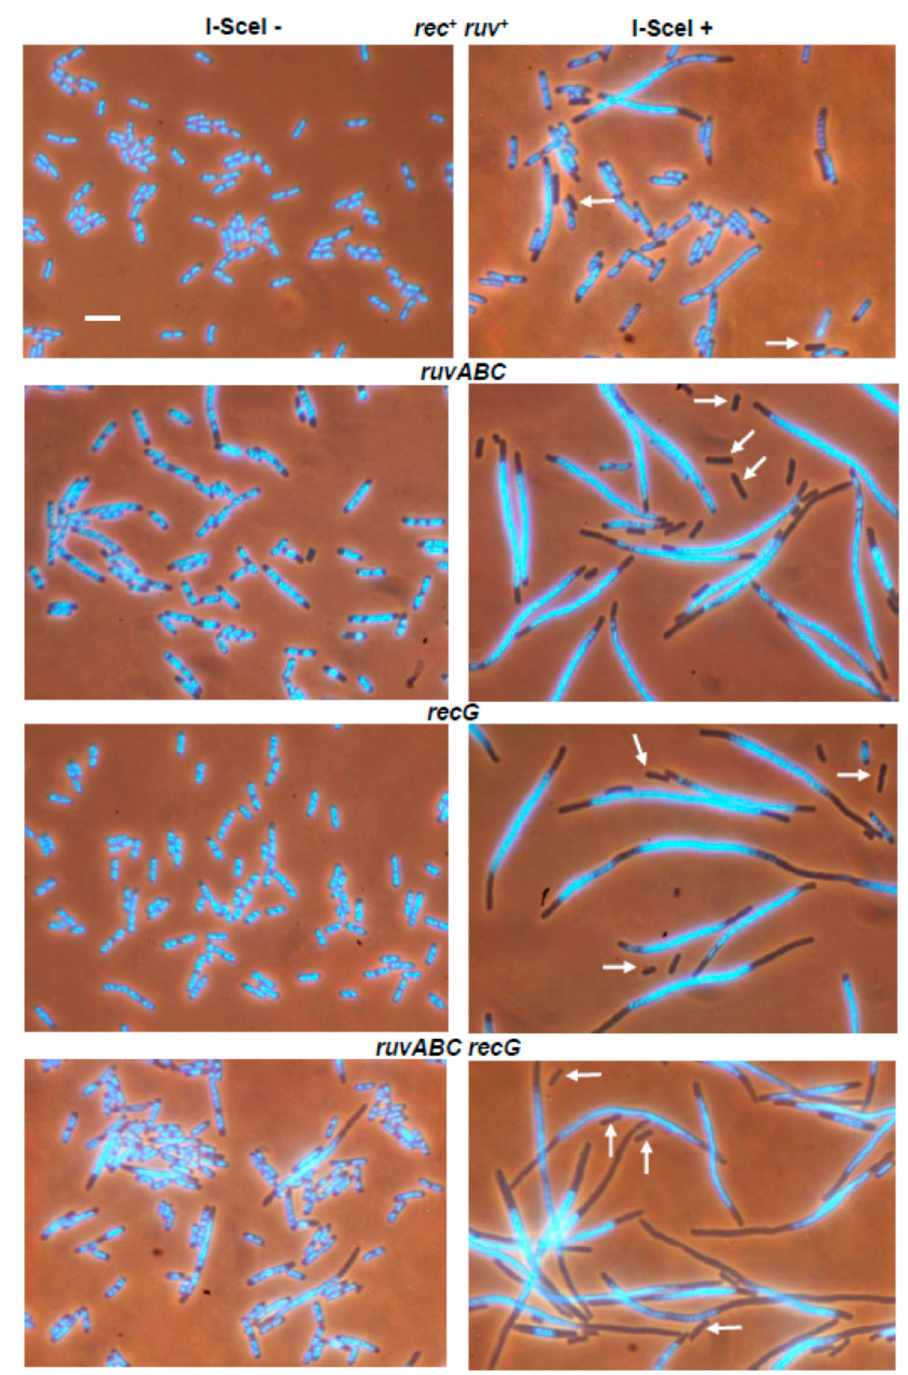
Figure 1. Changes in chromosome segregation and cell division induced by expression of I- Sce I endonuclease. Cell samples were taken before (left side of the panel) and after expression of I- Sce I (right side of the panel). Cells were fixed with osmium tetroxide, stained with DAPI and visualised using combined phase contrast and fluorescence microscopy. DAPI-stained chromosomes are seen as light blue structures within the dark outlines of cells. Arrows indicate anucleate cells. Bar, 5 μ m.